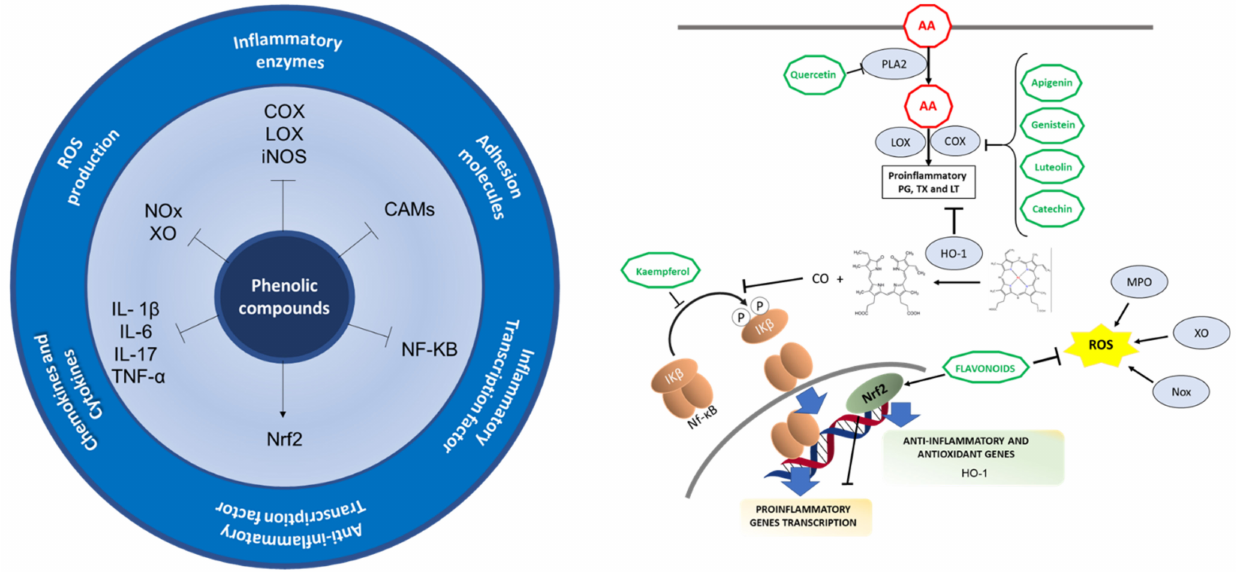
Figure 4. Anti-inflammatory mechanisms in which natural phenolic compounds are involved. Arrows and bar-headed lines mean activation and inhibition of the pathway